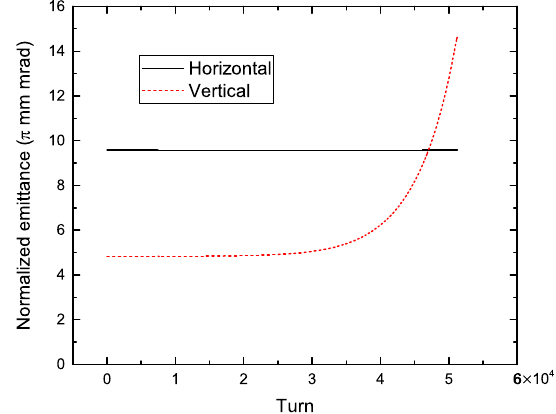
FIG. 9. Normalized emittance in both directions changes over time in the U 34 þ simulation. The vertical normalized emittance increases a lot while the horizontal normalized emittance changes a little.